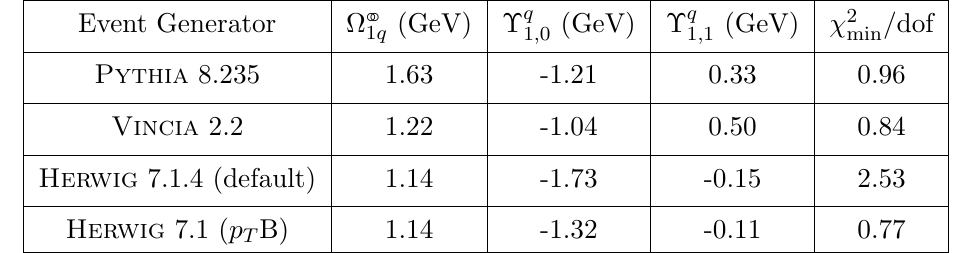
Table 1 . Summary of central (cid:12)ts for hadronic parameters in the SDOE region for di(cid:11)erent Monte Carlos. We also include a goodness of (cid:12)t measure with (cid:31) 2 the text.